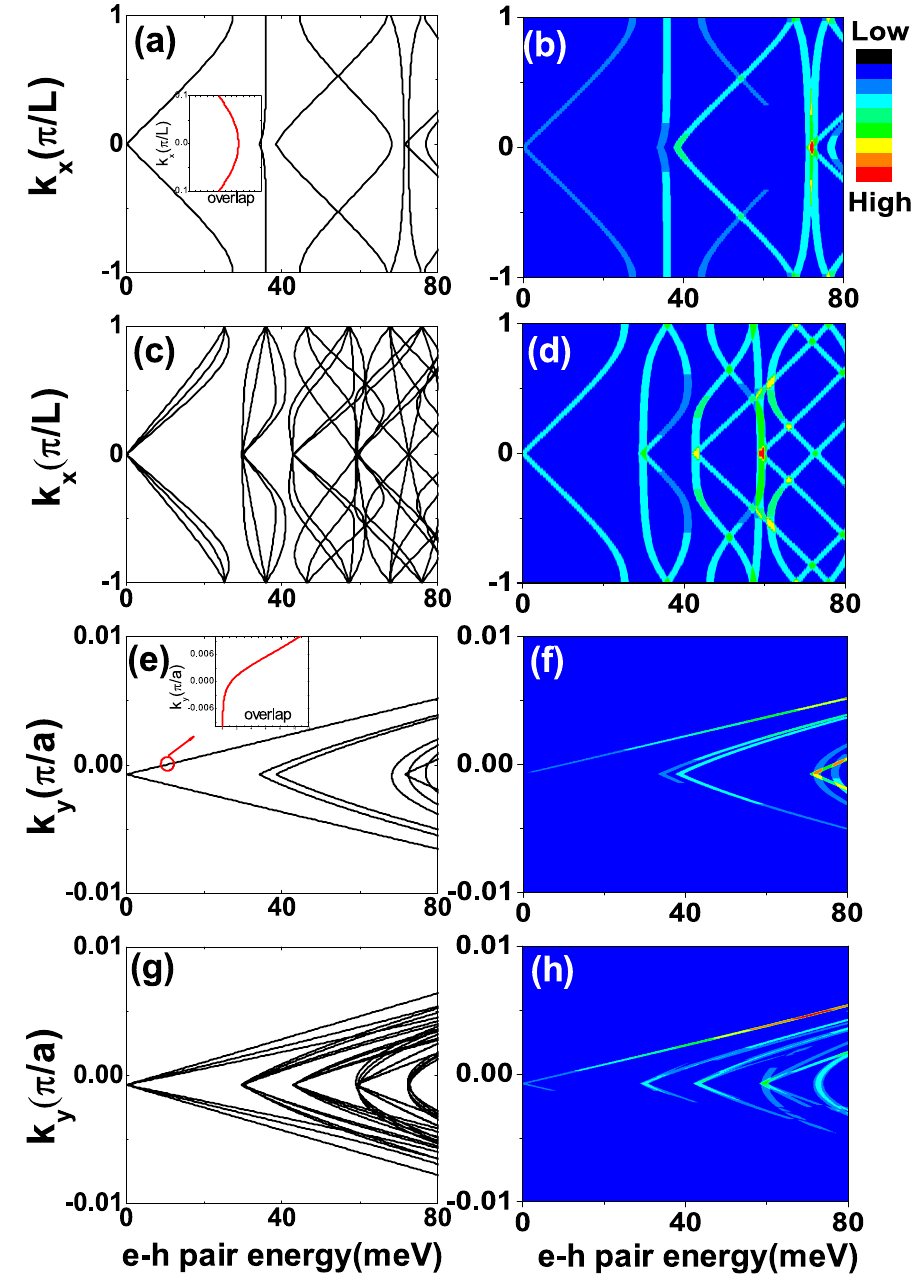
Figure 5. ( a ) The energy dispersions of e-h pairs as a function of wave vector k x with B = 1 T , R 0 = 0 around the band bottom. ( b ) The optical transition rate of e–h pairs as a function of wave vector k x B = 1 T , R 0 = 0. ( c and d ) are the same as ( a and b ) but including the RSOC term R 0 = 10 2 m / s . ( e–h ) are the corresponding energy dispersions and the optical transition rate as a function of the wave vector k y